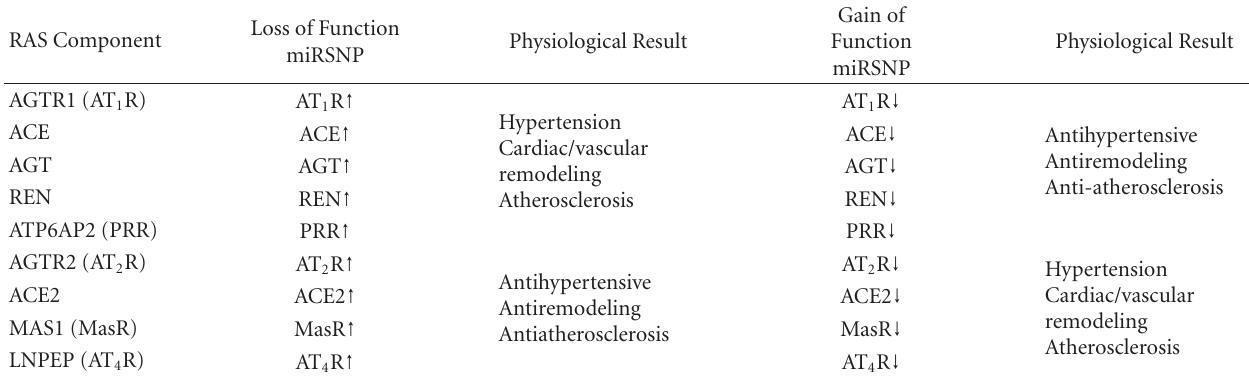
Table 3: Physiological ramifications of RAS